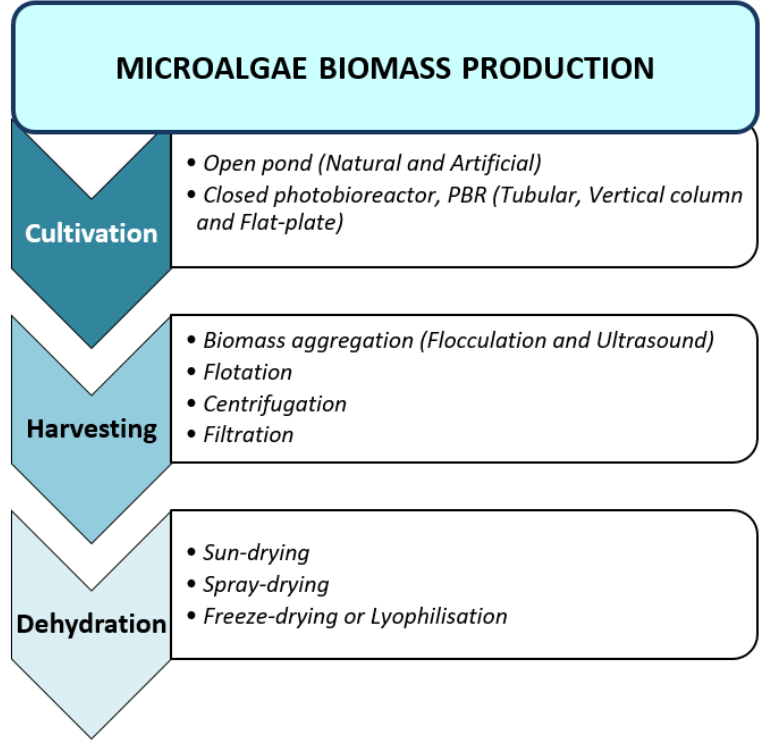
Figure 3. The production of microalgae biomass